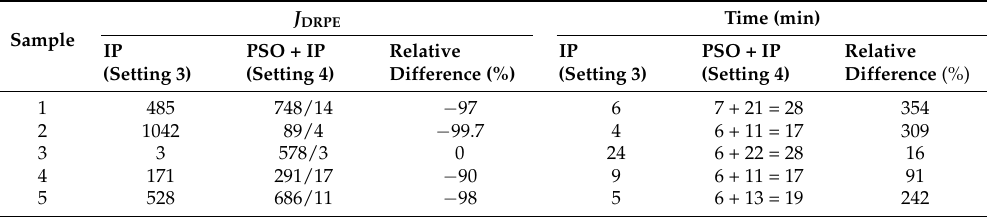
Table 12. Objective function values and computational cost as a function of problem formulation. J Sample